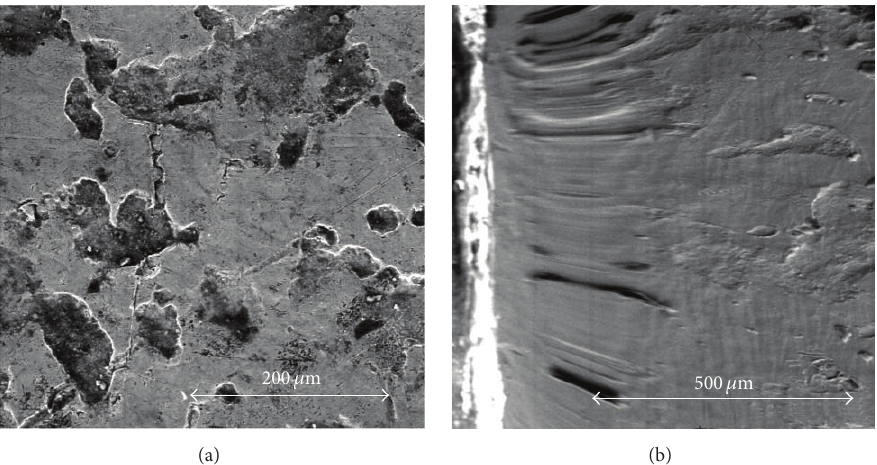
Figure 8: (a) Original morphology of zinc surface; (b) deformed Zn coating in the direction of tensile force after lap shear test (adhesive A).